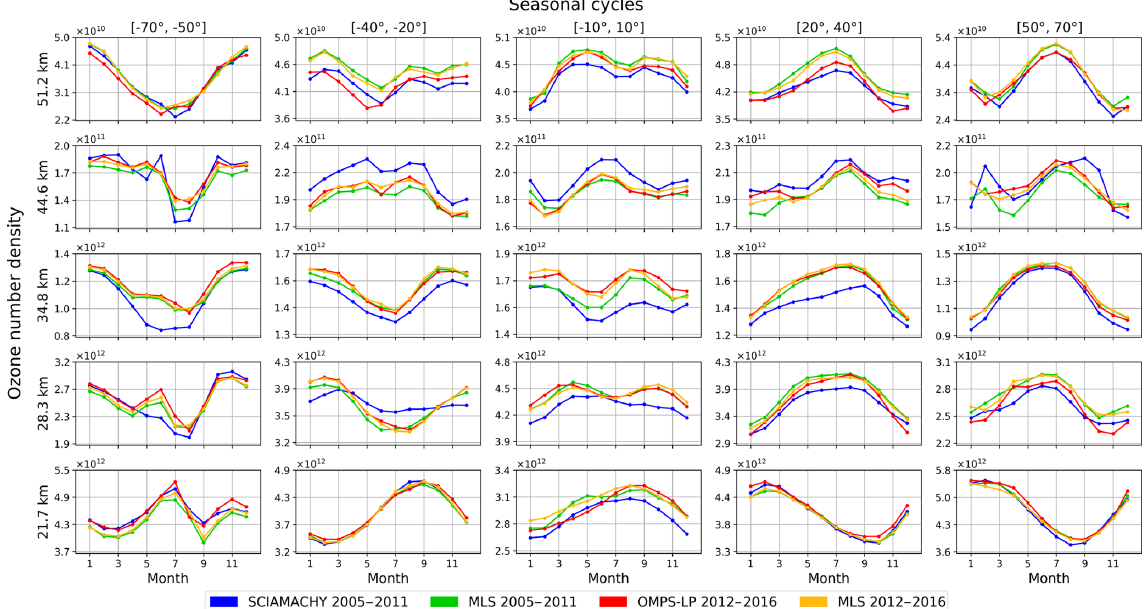
Figure 2. Seasonal cycle (SC) for the three instruments as a function of latitude and altitude, in terms of ozone number density (molec . cm − 3 ). MLS SC is plotted for the overlapping period with SCIAMACHY (2005–2011) and with OMPS-LP